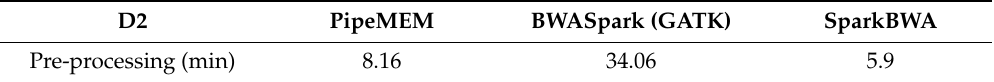
Table 5. Time consumption of the pre-processing in PipeMEM, BWASpark, and SparkBWA. D2